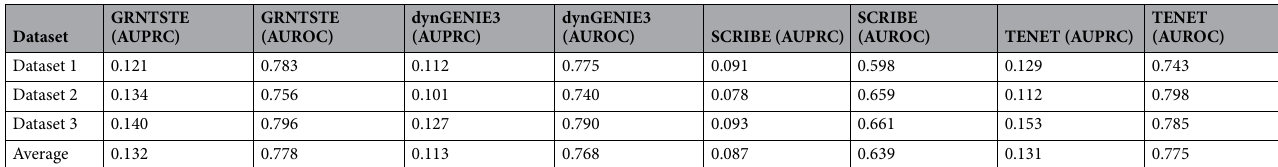
Table 1. Values of AUPRC and AUROC obtained for GRNTSTE, dynGENIE3, SCRIBE and TENET algorithms on the datasets with 10 genes.